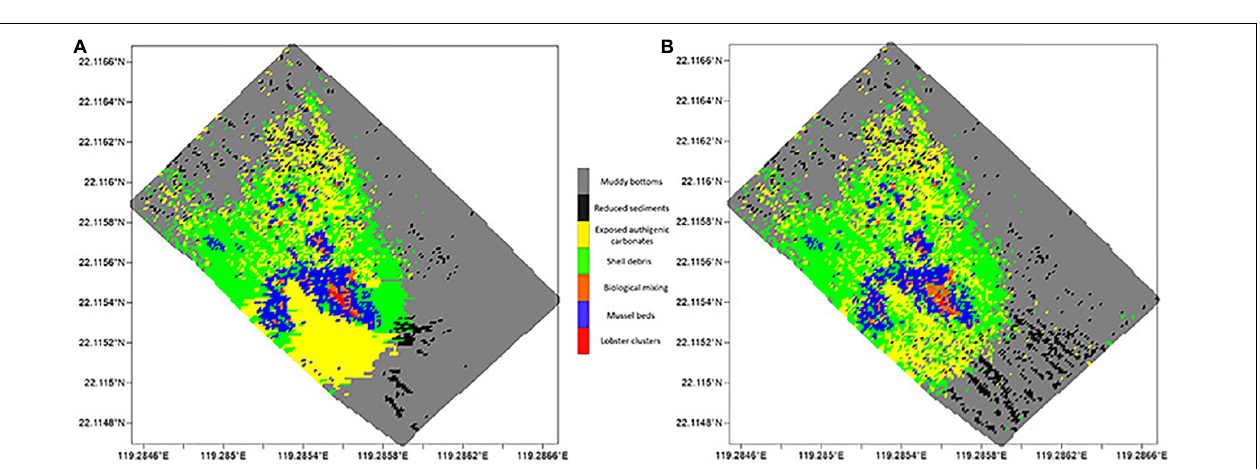
particularity of cold seeps. Although single-stage detection of cold seep epifauna due to the lower average precision.